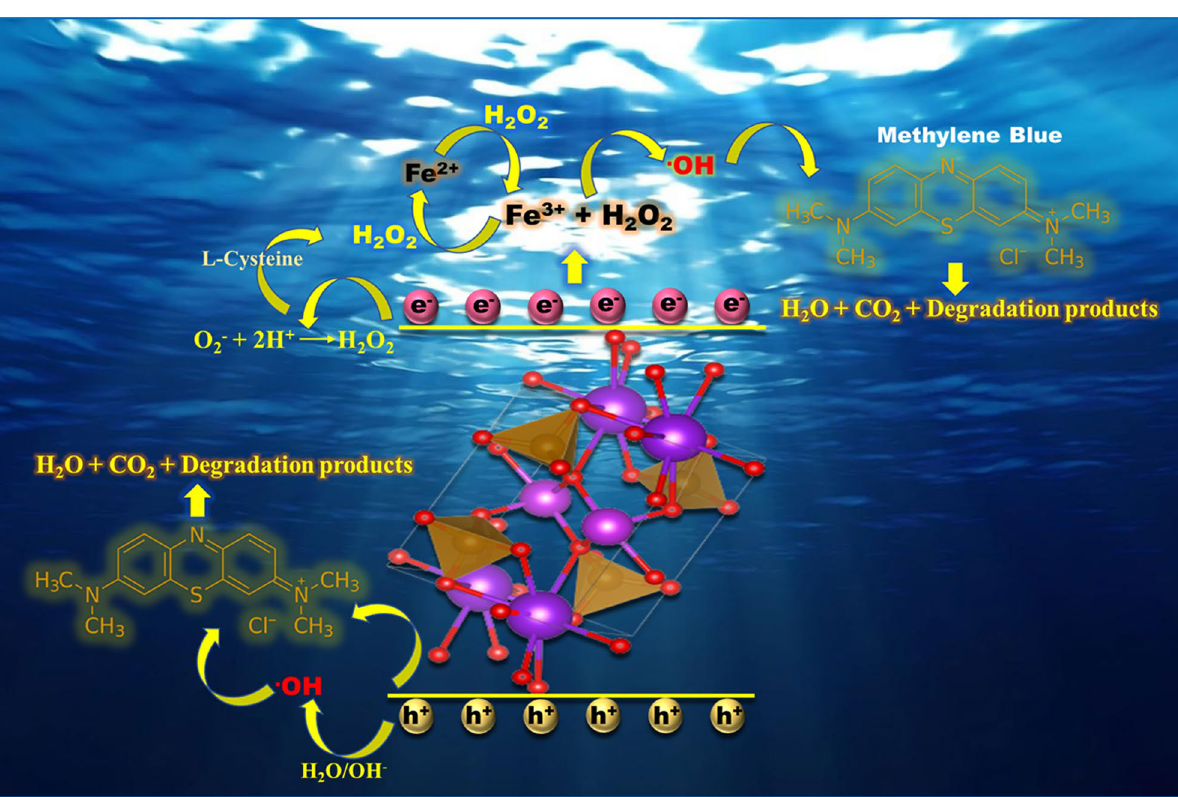
Figure 8. Photo-fenton degradation mechanism of MB using 20N-KBFO + H 2 O 2 +